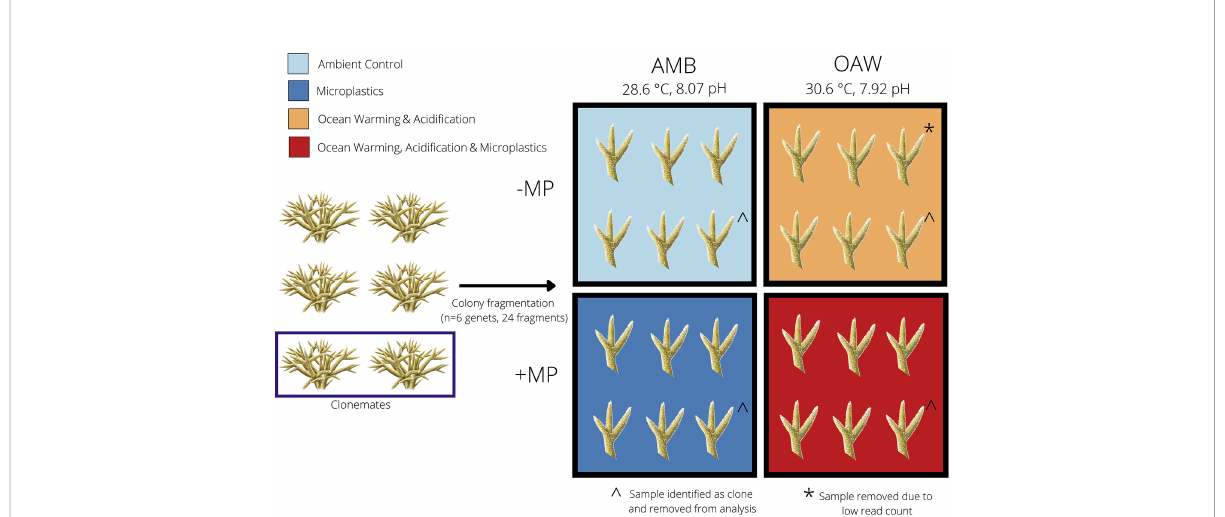
FIGURE 1 Experimental design to test the effects of ocean warming, acidi fi cation, and microplastics on the endangered coral Acropora cervicornis . Four fragments from each of six A. cervicornis genotypes that were used in downstream sequencing were assigned one of four experimental treatments: ambient conditions (AMB; blue), ocean acidi fi cation and warming (OAW; orange), microplastics (MP; dark blue), and OAW and MP (OAW+MP; red). Fragments were maintained individually in isolated tanks not depicted in this diagram. The dark blue rectangle (left) showcases two corals that were identi fi ed as clones via SNP calling from TagSeq gene expression data and the ^ symbol indicates the clone pair that was removed. The asterisk (*) indicates one gene expression library that was removed from downstream analysis due to low read